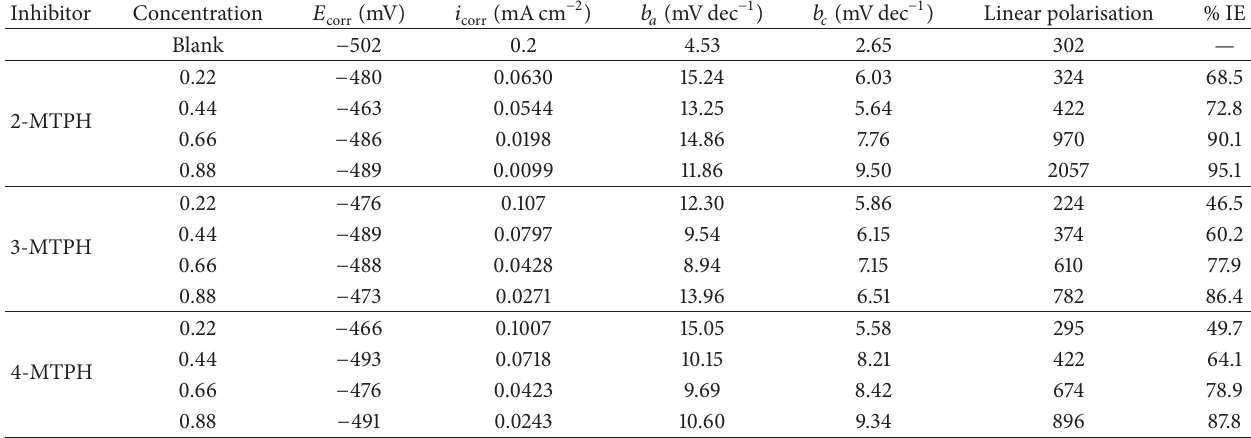
Figure 6: Tafel plots for MS in 0.5 M HCl containing different concentration of (a) 2-MTPH, (b) 3-MTPH, and (c) 4-MTPH. Table 5: Potentiodynamic polarization parameters for the corrosion of MS in 0.5 M HCl in the absence and presence of different concentrations of 2-MTPH, 3-MTPH, and 4-MTPH at 303